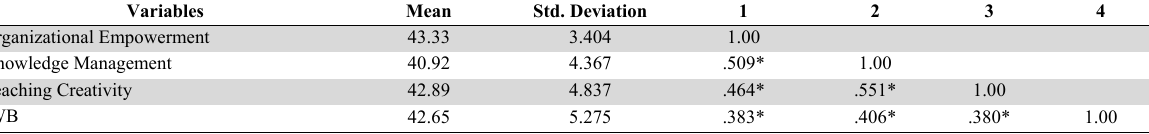
Descriptive Statistics and Correlation Matrics Variables Mean